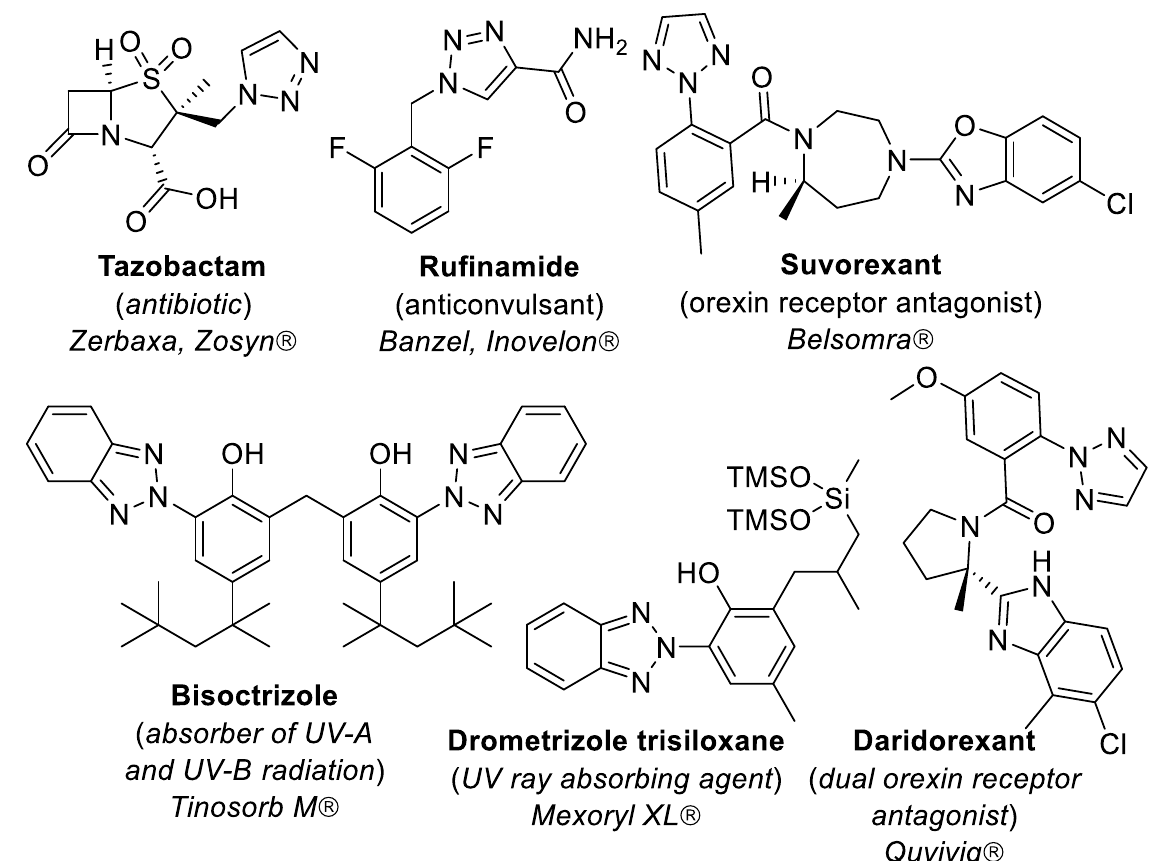
Figure 1. 1,2,3-Triazole-containing marketed drugs.